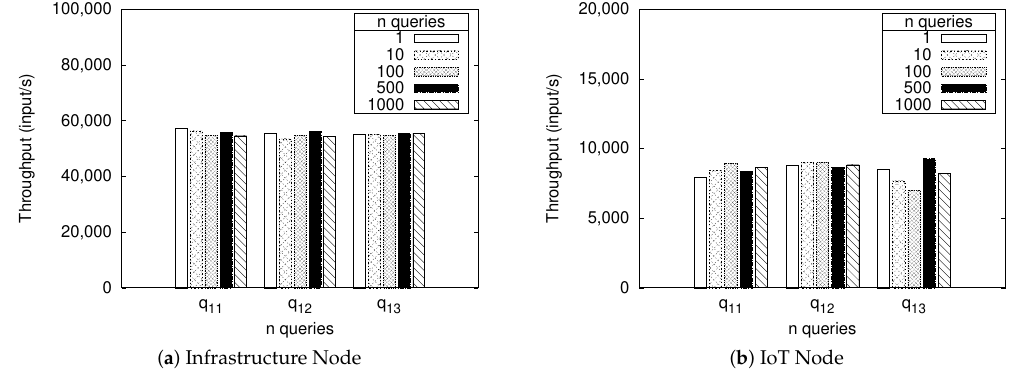
Figure 13. Processing throughput of stream query